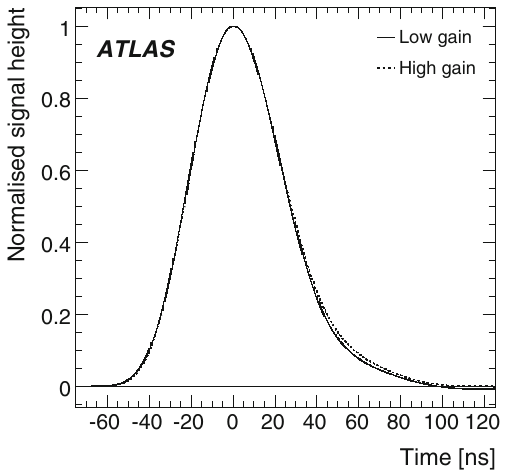
Fig. 2 The reference pulse shapes for high gain and low gain, shown in arbitrary units [6]